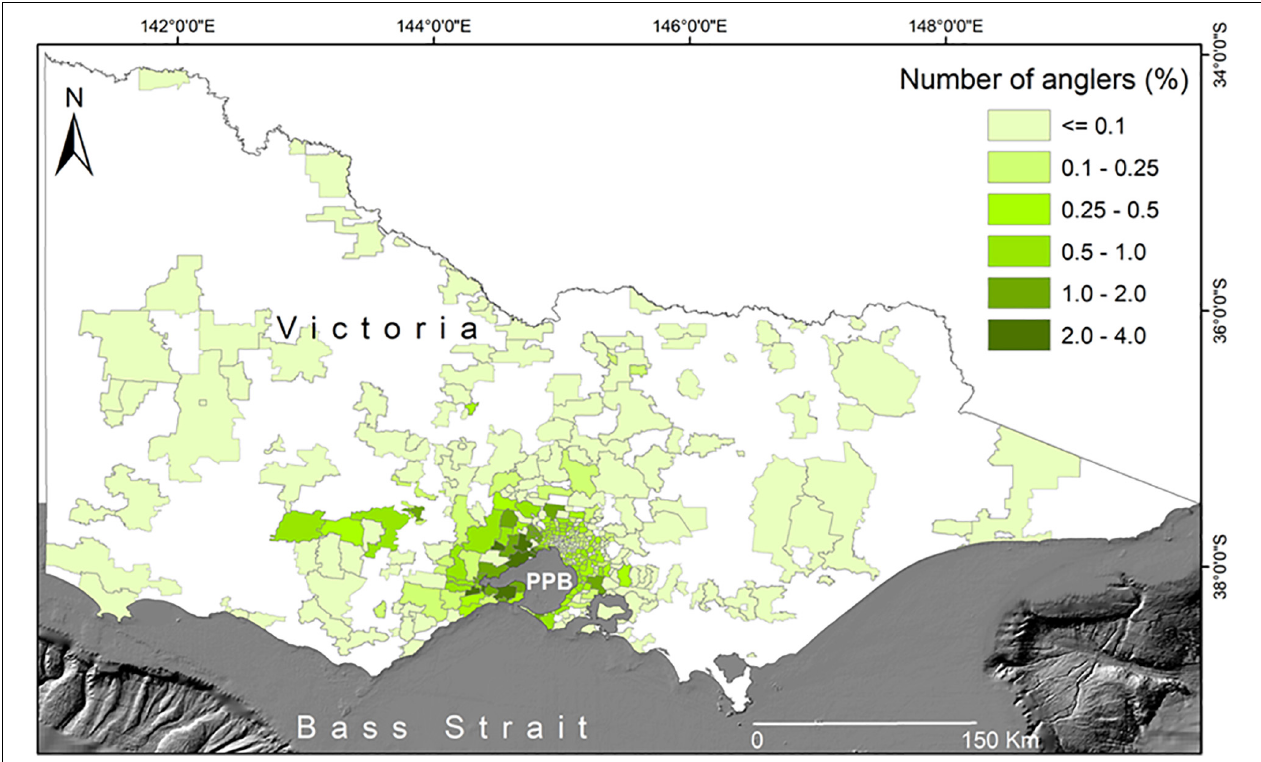
FIGURE 2 | Classified heatmap showing patterns in the percentage of interviewed anglers targeting Port Phillip Bay, based on their residential postcodes in Victoria with the data being pooled among years and species.